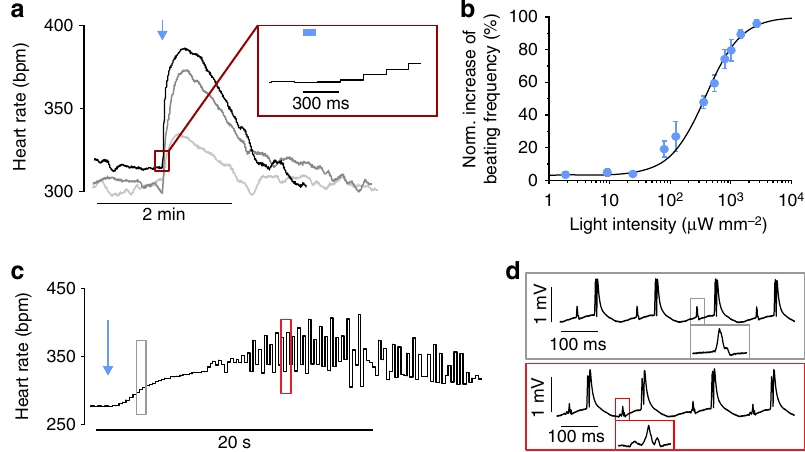
Fig. 6 Spatial difference of JellyOp stimulation in the left and right atria. a Representative heart rate traces upon brief (blue arrow, 100 ms) illumination of the anterior right atrium with 80 (gray), 540 (dark gray), and 1015 (black) µ W mm − 2 . Insert (red box) highlights the short delay between light (blue bar) and start of heart rate acceleration. b Statistical analysis of experiments described in ( a ) showing the relationship between normalized peak heart rate increase and light intensity fi tted with Hill equation ( n = 7). c Representative heart rate trace upon illumination of the dorsal left atrium (blue arrow, 190 μ W mm − 2 , 1 s) resulting in irregular beating. d ECG traces from the experiment shown in ( c ) before (gray box) and during a period with premature atrial contractions (red box) indicated by altered P -wave morphology (see inserts). Error bars: S.E.M.